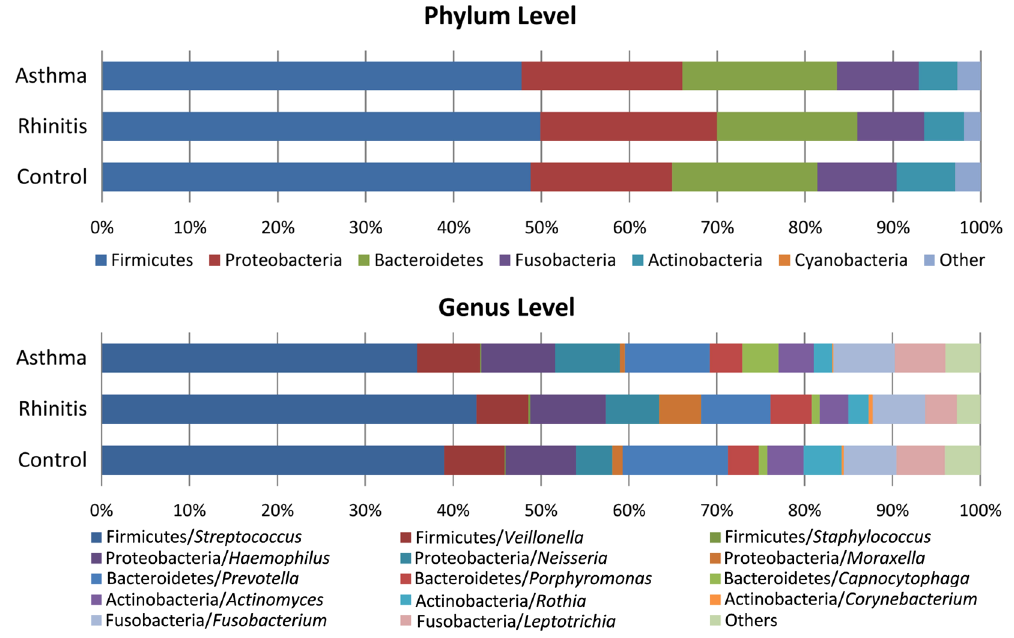
Figure 1. Bacterial composition and abundance at phylum and genus levels. Each row represents the distribution of the five most abundant phyla and their three most common genera in children with asthma, rhinitis and healthy controls. The color of each cell indicates the relative abundance of bacterial phyla and genera.